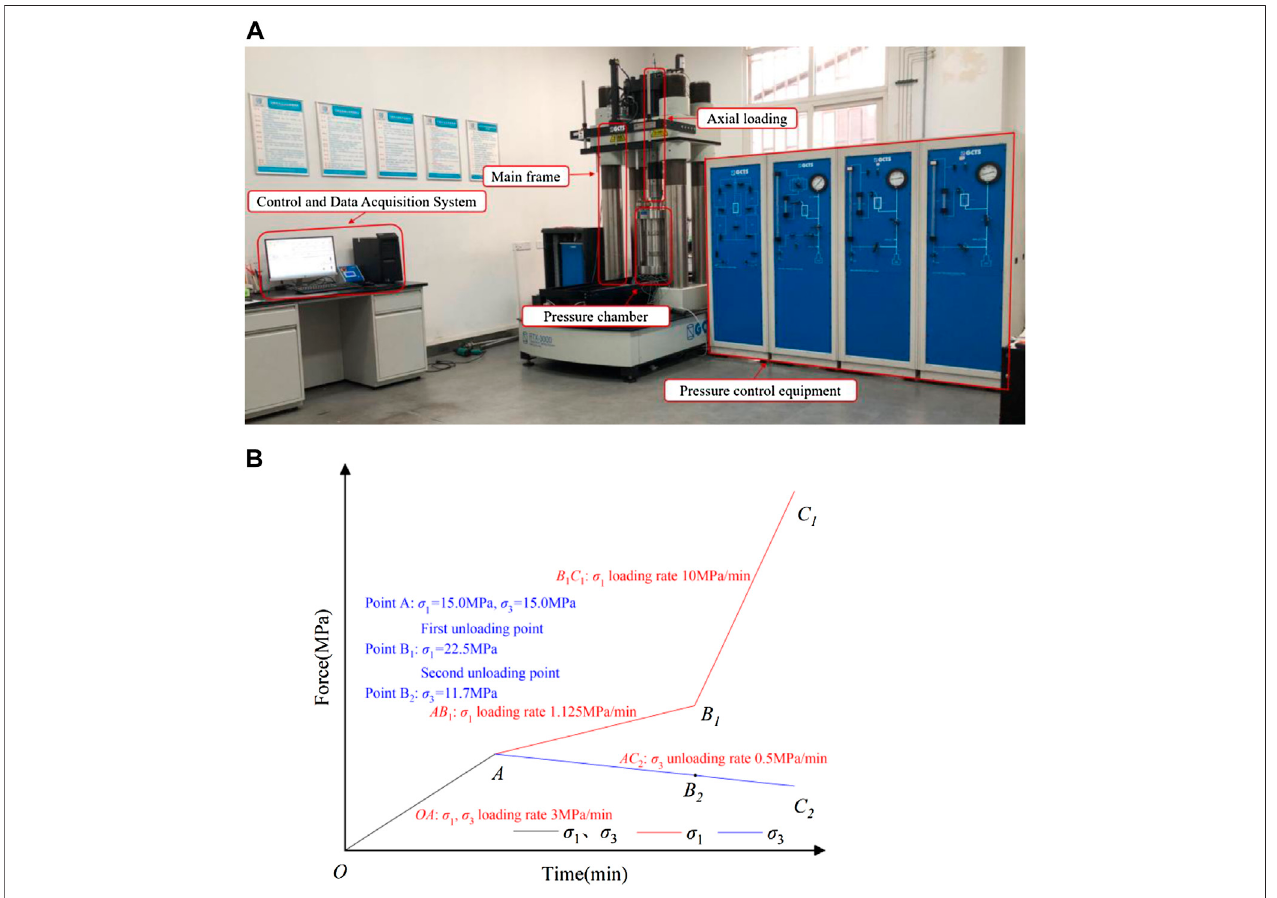
FIGURE 2 | Test equipment and plan. (A) The true-triaxial module of GCTS triaxial rock testing system (RTX-3000). (B) The stress path of σ 1 and σ 3.